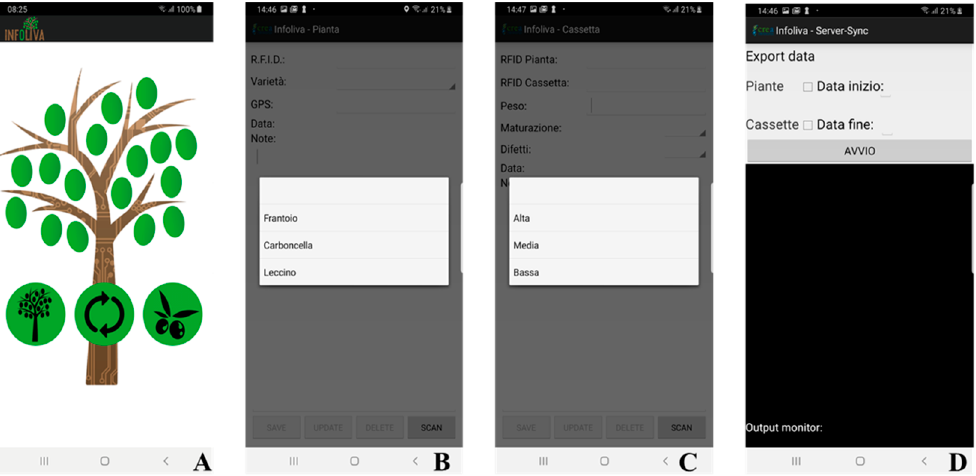
Figure 3. ( A ) Main activity of the Infoliva app (written in Italian to be used by local operators); ( B ) activity regarding the standing olive tree cultivar (Carboncella, Frantoio, Leccino), GPS (automated inserted and unmodifiable), date (data; automated inserted and unmodifiable) and notes; ( C ) activity regarding the olive harvest phase crate weight, olive maturation (high, medium, low), olive defects (high, medium, low), date (data; automated inserted and unmodifiable) and notes; ( D ) activity regarding the synchronization phase with the remote server and blockchain. The app was developed to be used by Italian users and could be easily modified in other languages and including other fields.